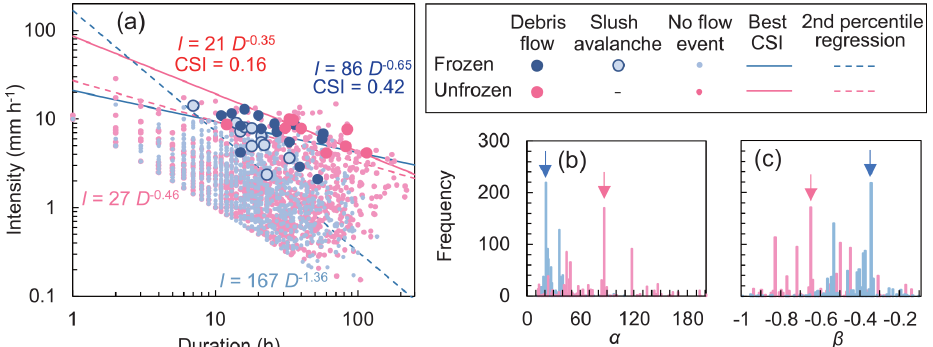
Figure 9. Intensity–duration thresholds for triggering debris flows and slush avalanches. (a) Comparison of the duration and intensity of rainfall events with or without debris flows and slush avalanches for rainfall events in frozen and unfrozen periods. Solid lines in the plots indicate the rainfall threshold, which optimally separated rainfall events that induced debris flows and slush avalanches from those that did not. Dashed lines in the plots indicate 2nd percentile regression lines that represent the lower-limit condition for the occurrence of sediment transfer. Frequencies of (b) constant α and (c) the slope of the power-law curve β , which produced the highest critical successful index (CSI), obtained by 1000 bootstrap resamplings are also shown in the figure. Arrows indicate values that produced the highest CSI in the analysis using the original dataset (solid line in a